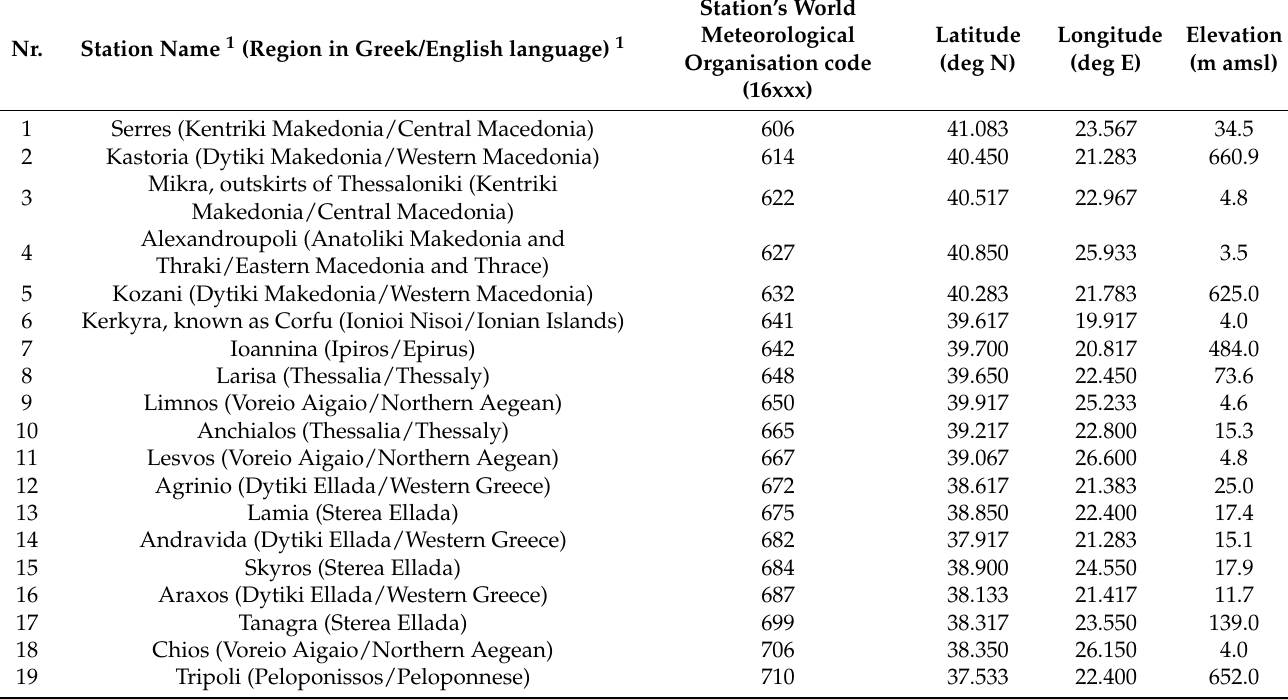
Table 2. Meteorological sites of the Hellenic National Meteorological Service (HNMS) network used in this study.